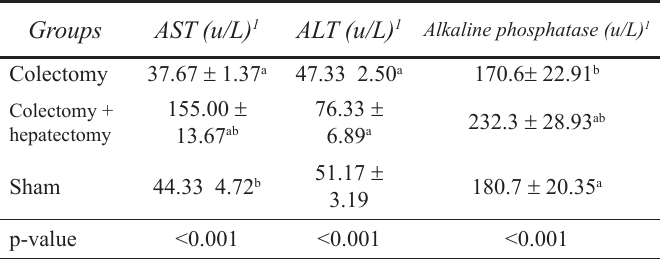
TABLE 2 - Serum levels of liver enzymes and